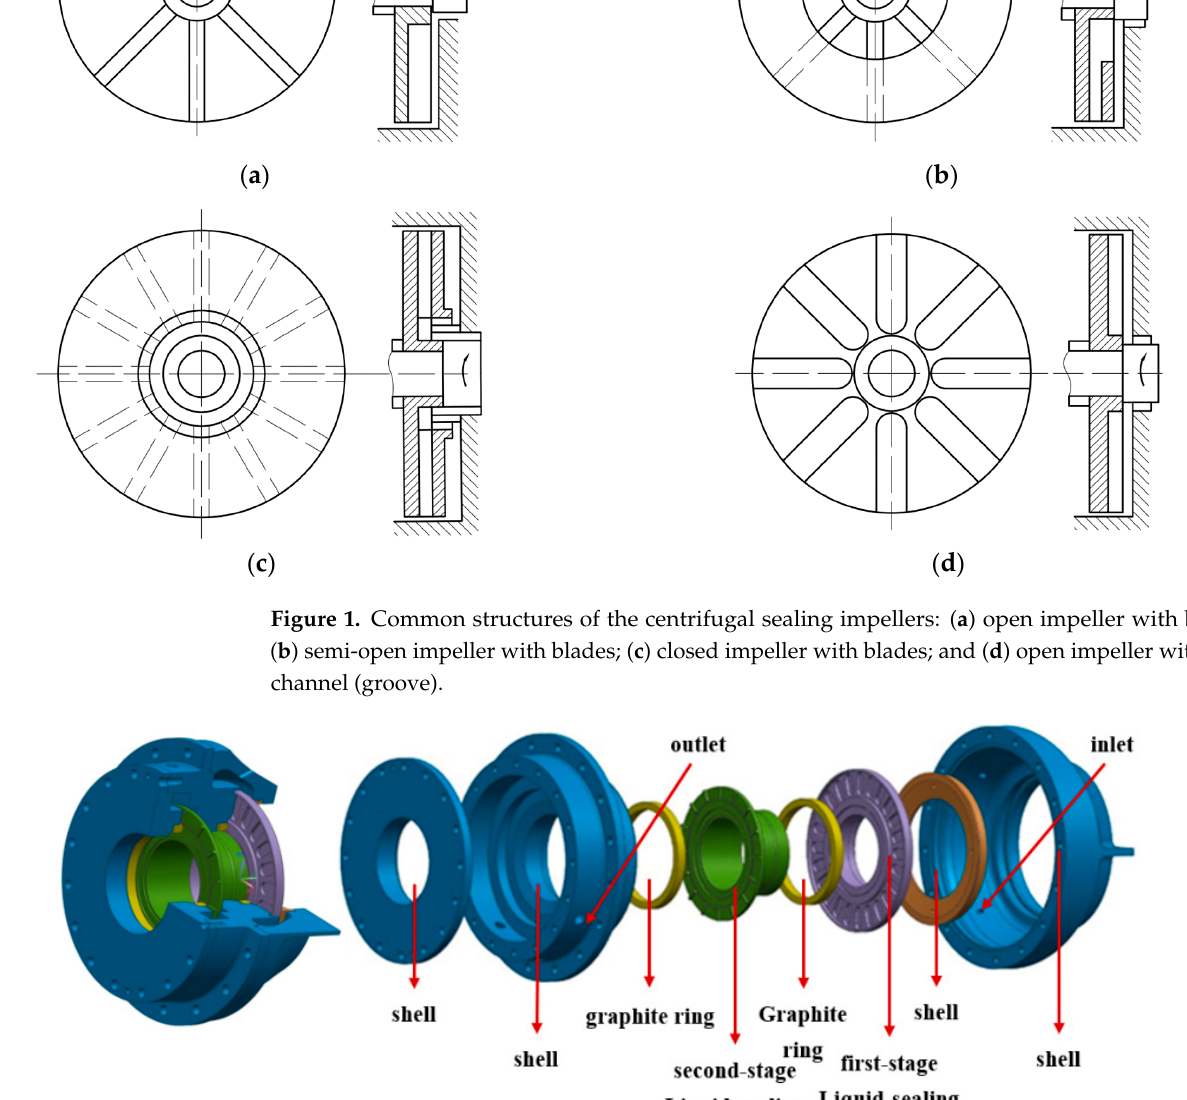
Figure 2. Three-dimensional model of multistage liquid-sealing impellers. The first-stage liquid-sealing impeller of the multistage liquid-sealing impeller is an open impeller with a flow channel (groove). Compared to the common open impeller with a flow channel (groove), the first-stage liquid-sealing impeller is also provided with